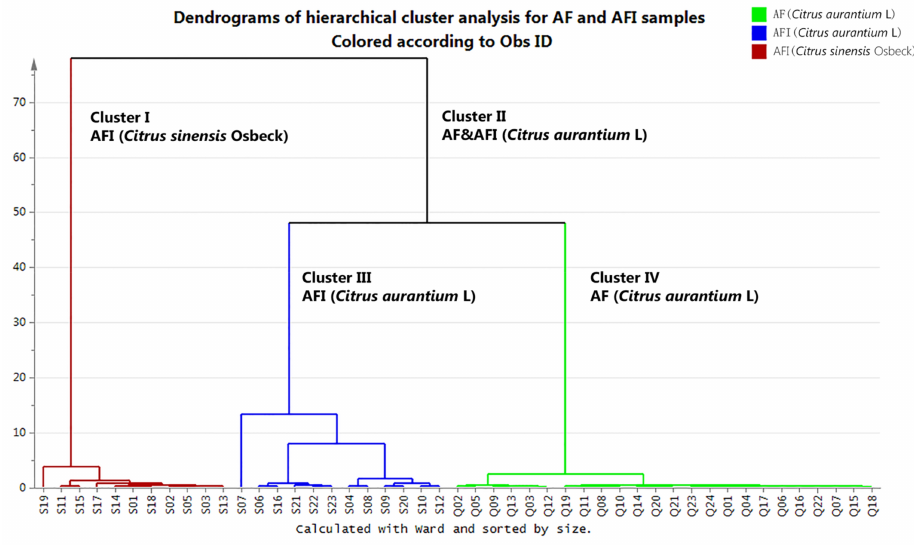
Figure 5. Evaluation of the differences between AF and AFI with hierarchical cluster analysis